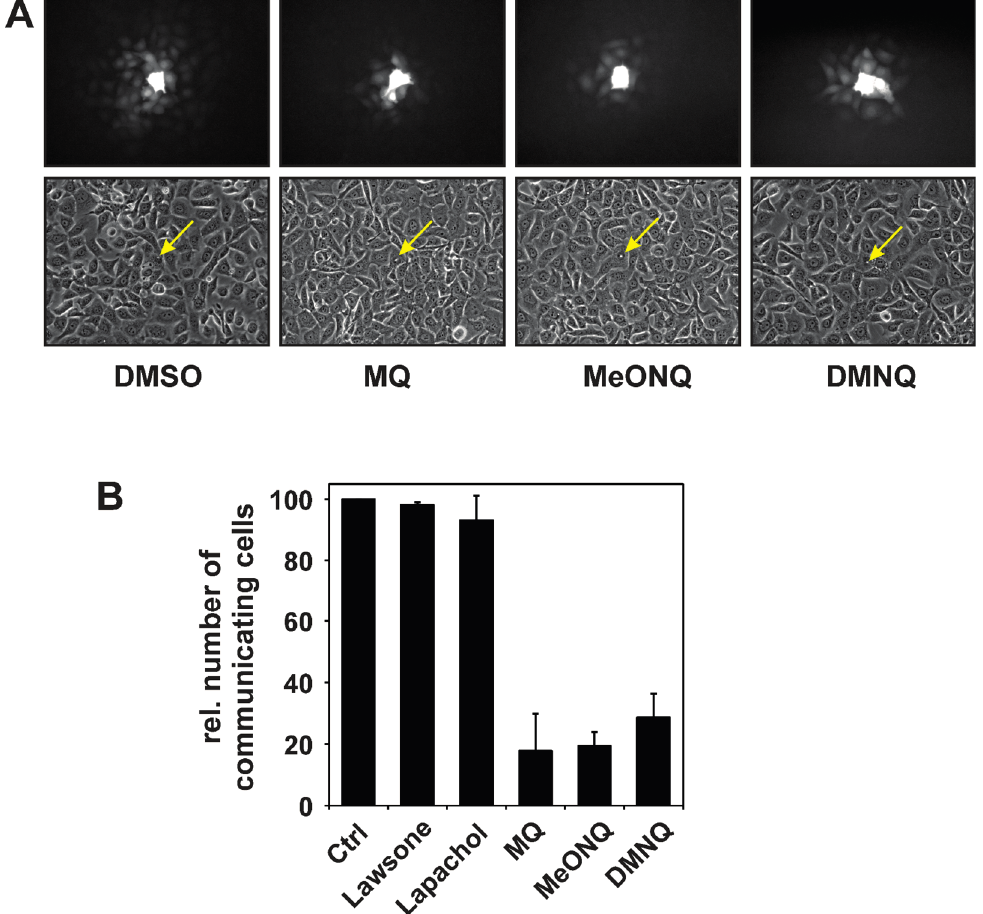
Figure 2. Loss of gap junctional intercellular communication (GJIC) in cells exposed to naphthoquinones. WB-F344 rat liver epithelial cells (a generous gift by Dr. James E. Trosko, Michigan State University, East Lansing, MI, USA) were grown to near confluence, followed by exposure to 10 µM of the given naphthoquinones (or DMSO as vehicle control) in serum-free cell culture medium (DMEM) for 60 min. Cells were washed with PBS and GJIC was determined by microinjecting the fluorescent dye Lucifer Yellow CH into selected cells as described previously [55,56]. One minute after injection, fluorescent cells surrounding the cells loaded with dye were counted and taken as a measure of